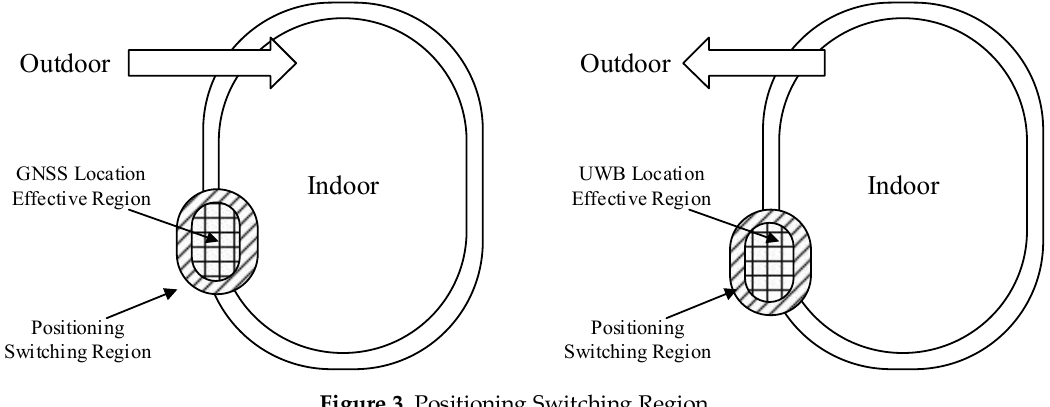
Figure 3. Positioning Switching